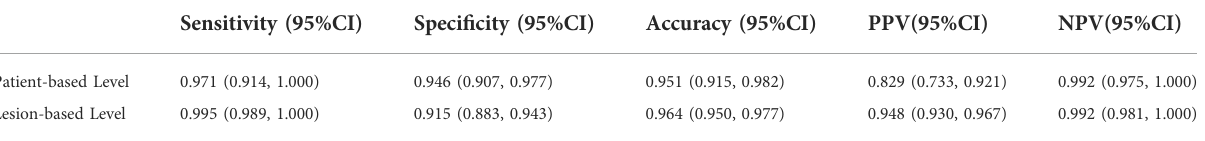
TABLE 2 The diagnostic results of visual analysis for diagnosing bone metastases (n =